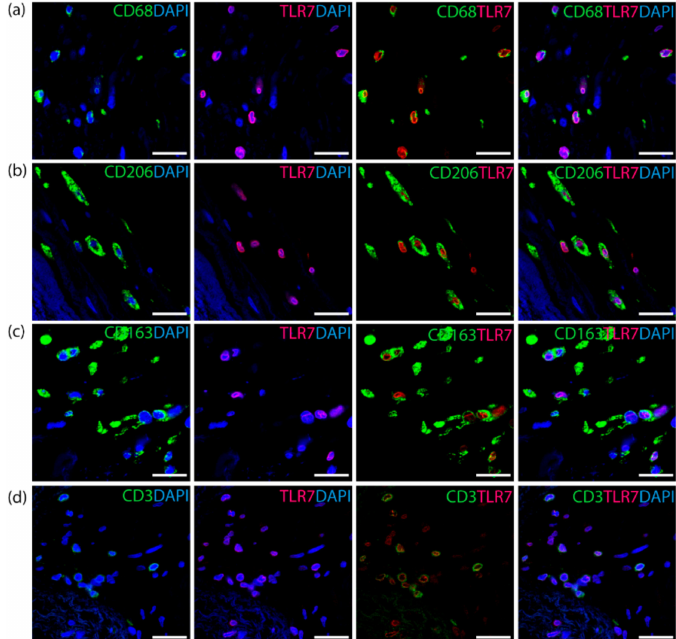
Figure 2. Co-localization of TLR7 and macrophage markers in human aortic valves, visualized by immunofluorescence staining. ( a ) TLR7 (red) is expressed in CD68 + (green) cells. ( b ) double staining of TLR7 (red) and CD206 (green). ( c ) co-localization of TLR7 (red) and CD163 (green). ( d ) TLR7 (red) is expressed in CD3 + (green) T cells. Nuclei are stained blue. Scale bars: 20 µ m.